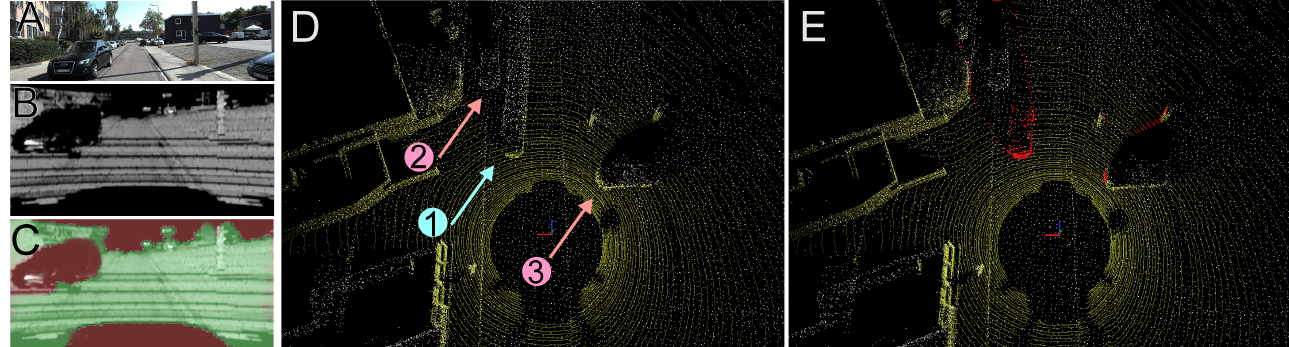
Figure 14. Detection and removal of non-stationary objects in a KITTI MOTS suburban scenario: frontal camera view ( A ), the corresponding synthesized intensity image ( B ), motion segmentation mask ( C ), accumulated point clouds showing the trail of laser points left by a moving car (denoted 1) and some parked cars (denoted 2 and 3) ( D ), and accumulated point clouds after removal of the non-stationary objects—note that the points corresponding to the moving car have been removed, while the parked (stationary) cars are still visible ( E ).